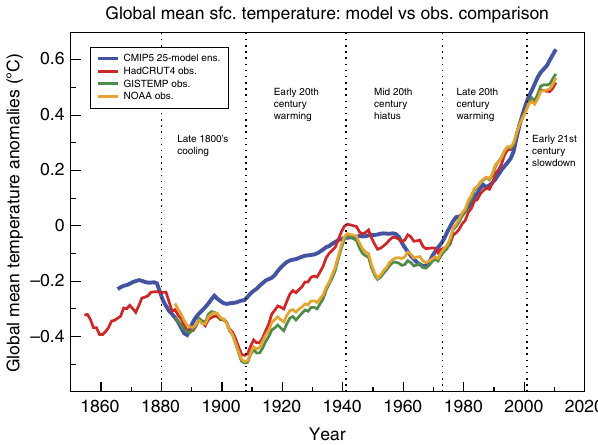
Figure 1 | Global mean temperature anomalies in observations compared with models. Ten-year running mean anomalies ( (cid:2) C) relative to a 1961–1990 reference period for observed data sets HadCRUT4.4 (ref. 50) (red line); GISTEMP 51 (green line), U.S. National Oceanographic and Atmospheric Administration (NOAA 2 , orange line) or the CMIP5 multi- model ensemble (25 models) of All-Forcing historical simulations 4 (blue line). Five epochs discussed in the paper are labelled, separated by dotted vertical